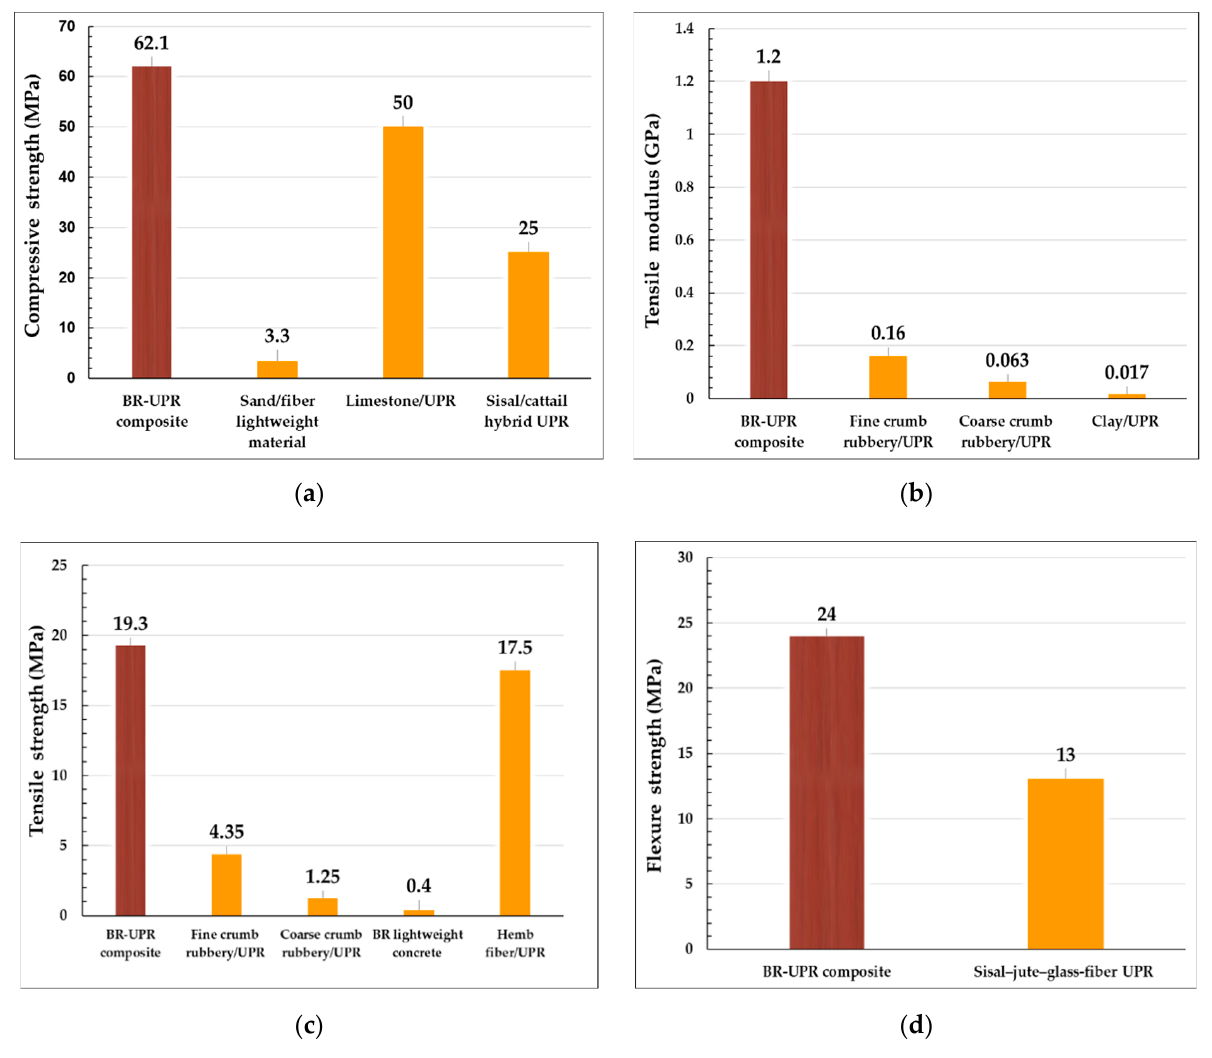
Figure 6. Mechanical properties of BR–UPR and other polyester composites ( a ) Compressive strength; ( b ) Tensile modulus; ( c ) Tensile strength; ( d ) Flexure strength. Table 3. Compressive, tensile, and flexure mechanical properties of BR–UPR composites.